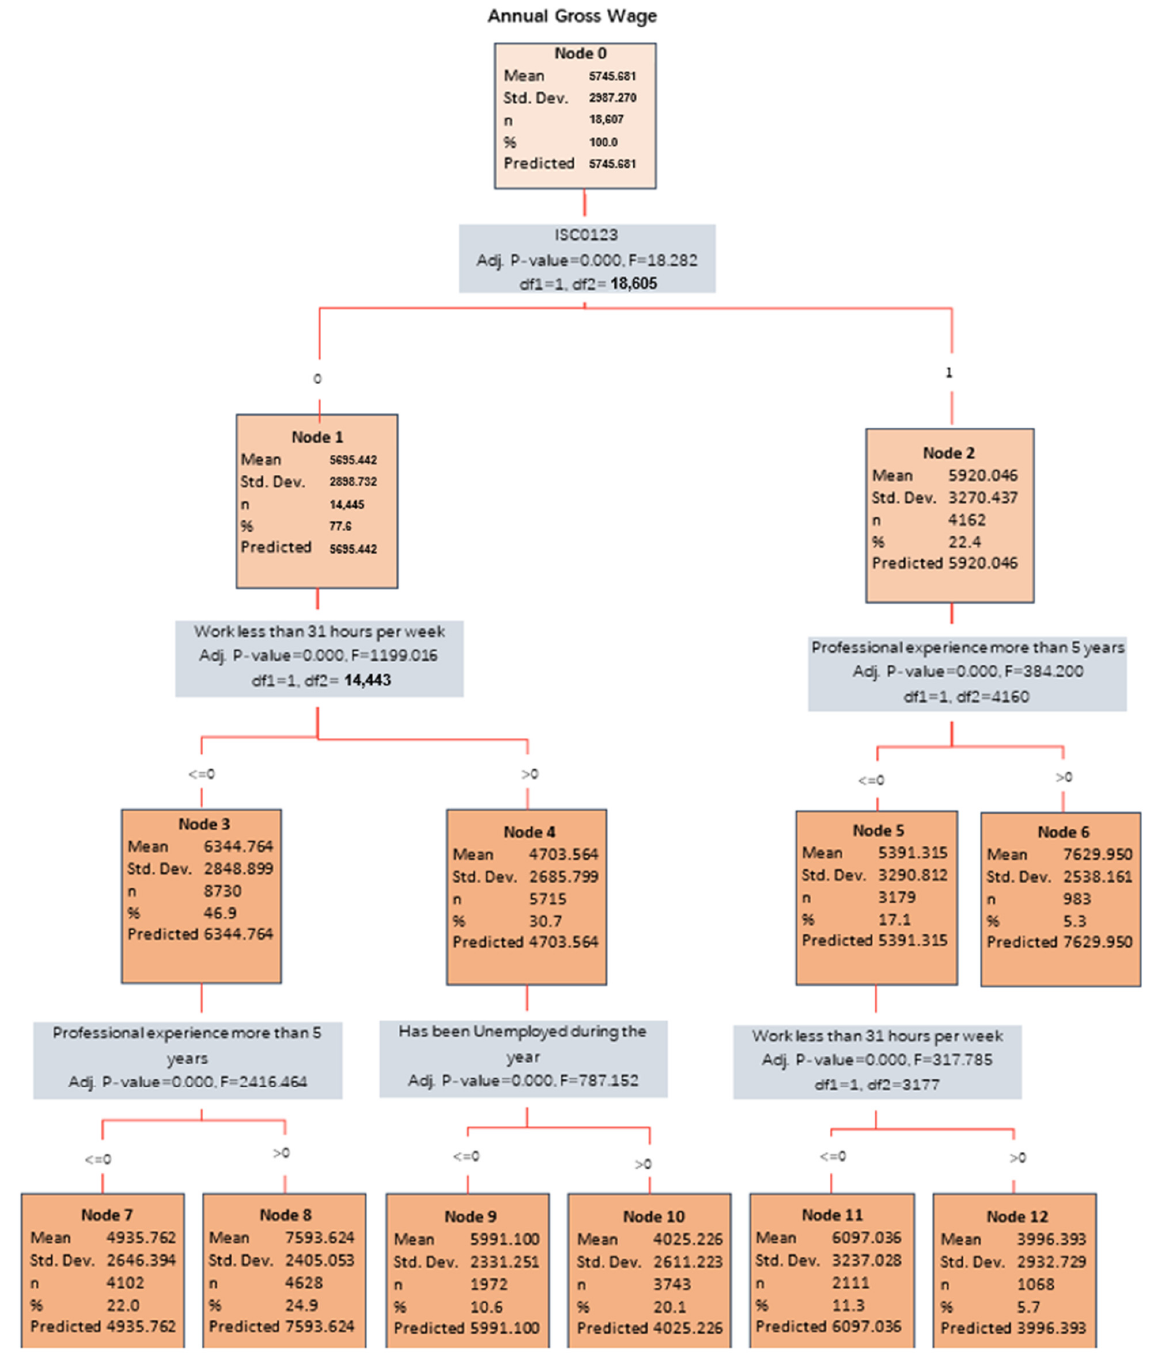
Figure 15. Internal divisions of precarious workers other than domestic. Data source: EU-SILC Eurostat (2020). Table 4. Definition of the variables of the logistic regression for the determination of personal char- acteristics affecting the risk of precariousness .